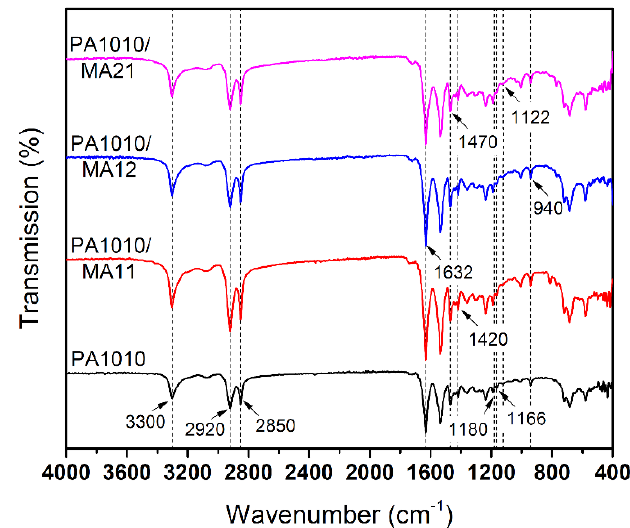
Figure 4. FTIR spectra of neat PA1010 and PA1010 filled with MA complexes.